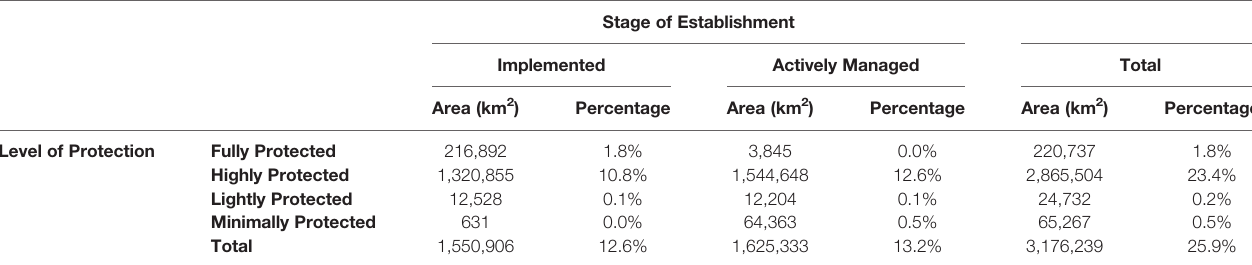
TABLE 2 | U.S. MPA area (km 2 ) in the largest 50 U.S. MPAs, assessed by level of protection and stage of establishment (excluding proposed/committed and designated, which are not yet in force on the water) using The MPA Guide . Stage of Establishment